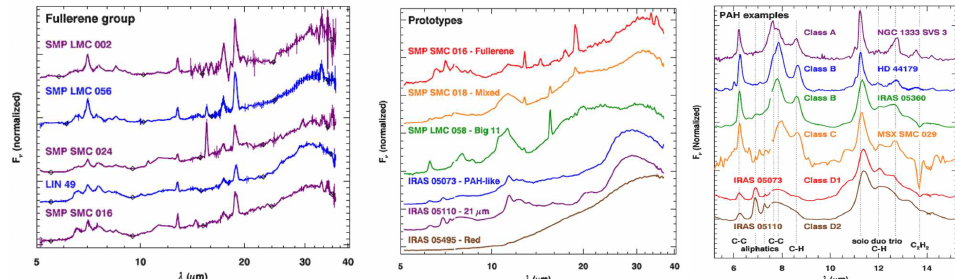
Figure 7. Carbon-rich dust features in pAGB objects in the Magellanic Clouds (adapted from [56]). ( left ) Spectra of fullerenes; ( center ) examples of the spectral groups into which carbon-rich pAGB objects have been grouped; ( right ) examples of spectra showing different classes of Polycyclic Aromatic Hydrocarbons (PAH) emission. Vertical dotted lines mark aliphatic modes at 6.9 and 7.27 µ m, aromatic modes at other wavelengths, and C 2 H 2 Q-branch absorption at 13.7 µ